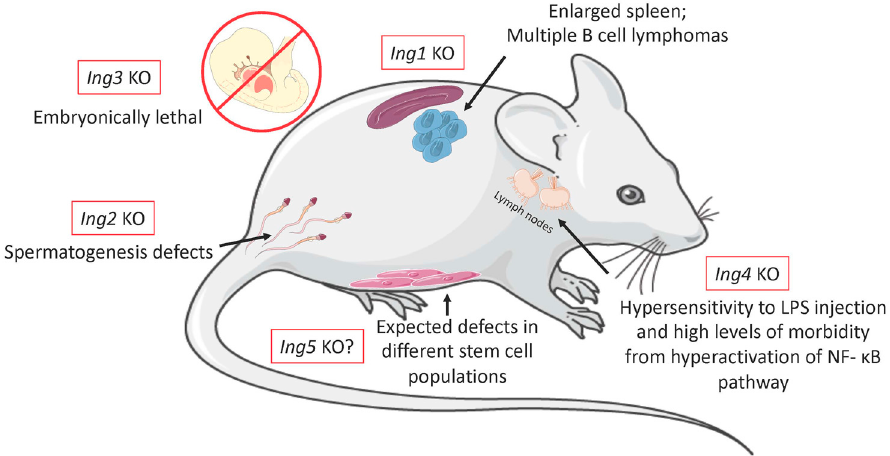
Figure 2 : Schematic figure showing the major phenotypes involved in the knockout animals for all the Ing proteins. Even though Ing proteins are relatively similar, their knockout phenotypes varied widely according to the protein deleted. ING1 knockout mice presented with reduced body sized, enlarged spleens and multiple B cells lymphomas. ING2 defective animals had deficient spermatogenesis. ING3 is the only Ing protein that was embryonically lethal, possibly because it is the most primordial of the family. ING4 mice were hypersensitive to LPS injection and presented problems with innate immunity. Lastly, there are still no knockouts for ING5, but based on the recent studies made in vitro that implicate ING5 in different stem cells processes, we expect to encounter some type of stem cell defect in these animals, possibly presenting as early age stem cell depletion or organogenesis defects.